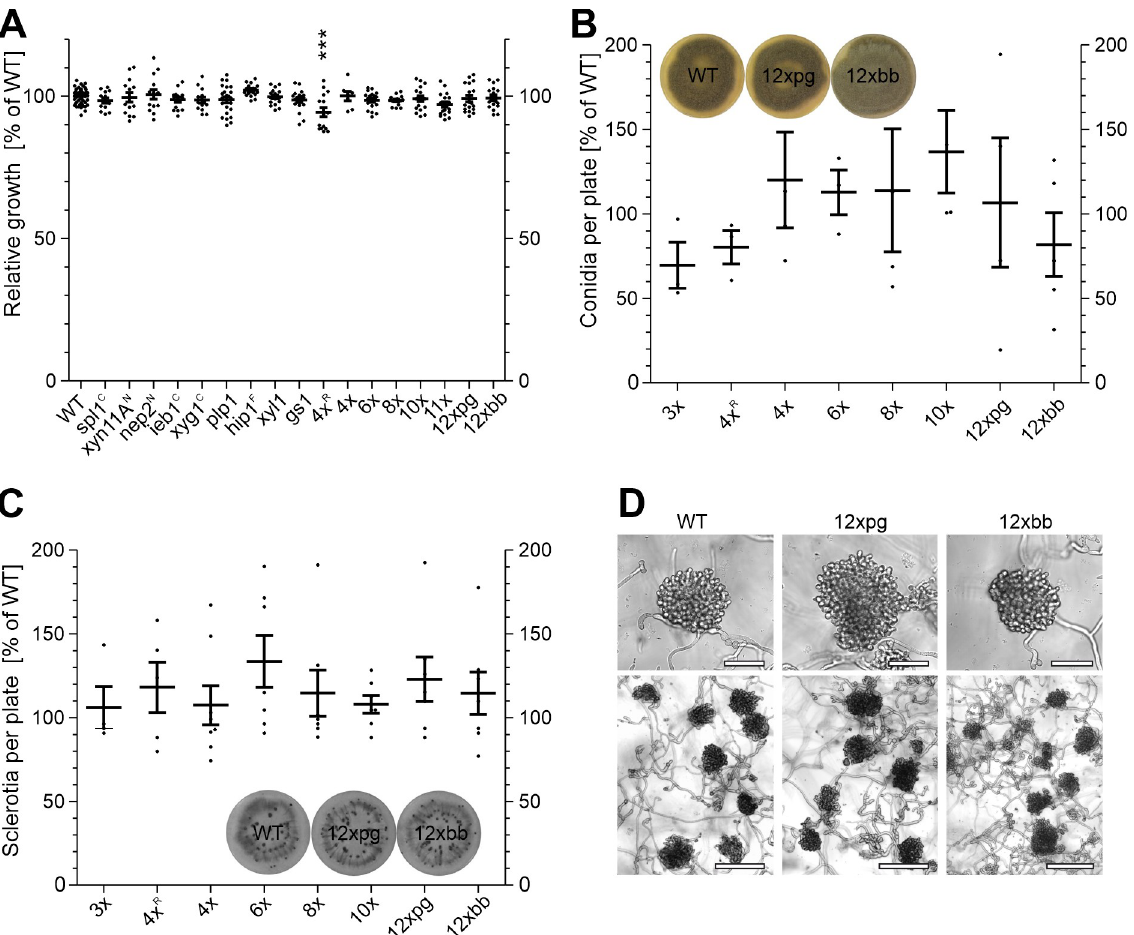
Fig 2. Growth and in vitro differentiation of B . cinerea B05.10 (WT) and mutants generated in this study. A: Relative radial growth on GB5 minimal agar medium with 25 mM glucose (3 days). One way ANOVA and Dunnett’s post-hoc test (control: WT) are displayed; ��� : p < 0.001. B: Conidia formation on ME plates incubated for 10 days under permanent light to induce conidia formation. C: Sclerotia formation on ME plates incubated for 14 days in darkness to induce sclerotia formation. Mutants marked with superscript letters were generated with resistance markers. For B and C, a one-sample t test against a hypothetical value of 100% (mean of WT) did not show any significant differences. For A-C, the means of three experiments, with one to three replicates each, are shown. D: Infection cushions formed on glass slides after 48 h. Upper scale bars: 50 μ m; lower scale bars: 150 μ m.